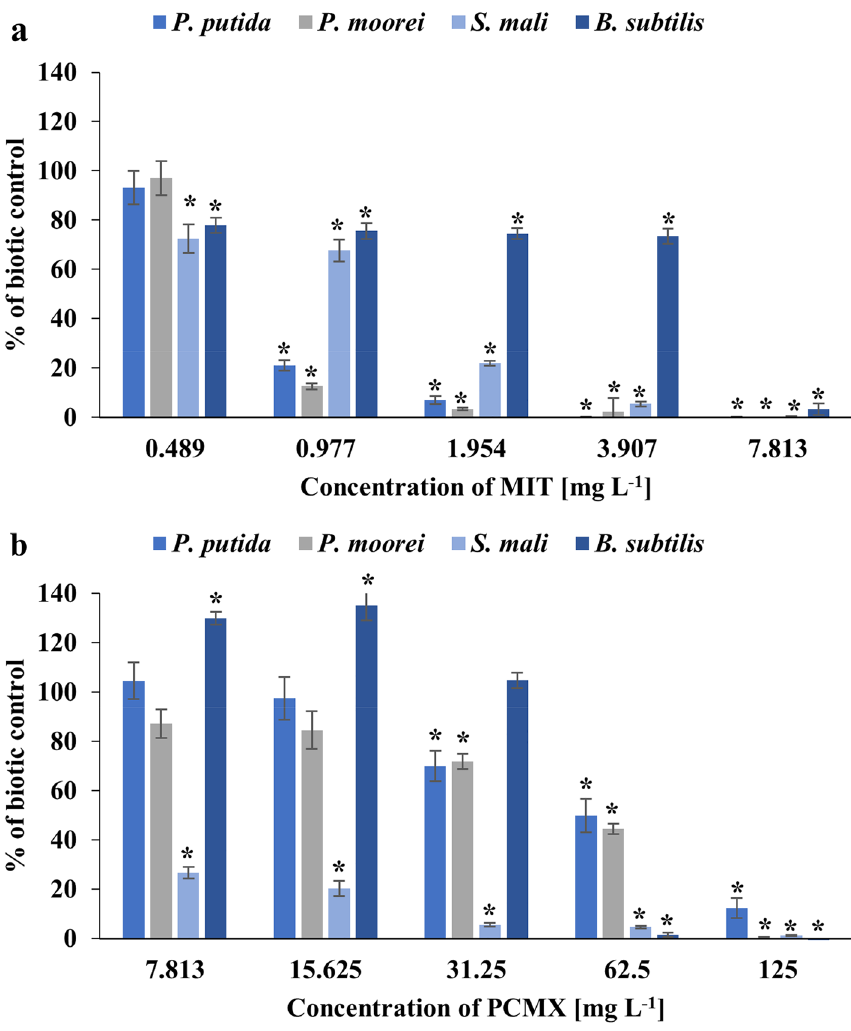
Figure 2. Reduction of resazurin by the tested strains incubated with the addition of methylisothiazolinone ( a ) or chloroxylenol ( b ). Data are expressed as the average percentage of bacterial growth (compared to biotic control) ± SD (n = 4). The presented results were analysed using the Mann ‒ Whitney U test with *p <